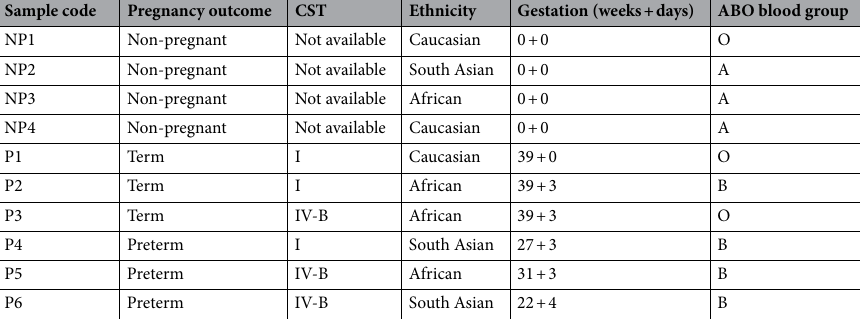
Table 1. Summary of CVF samples collected for glycomic